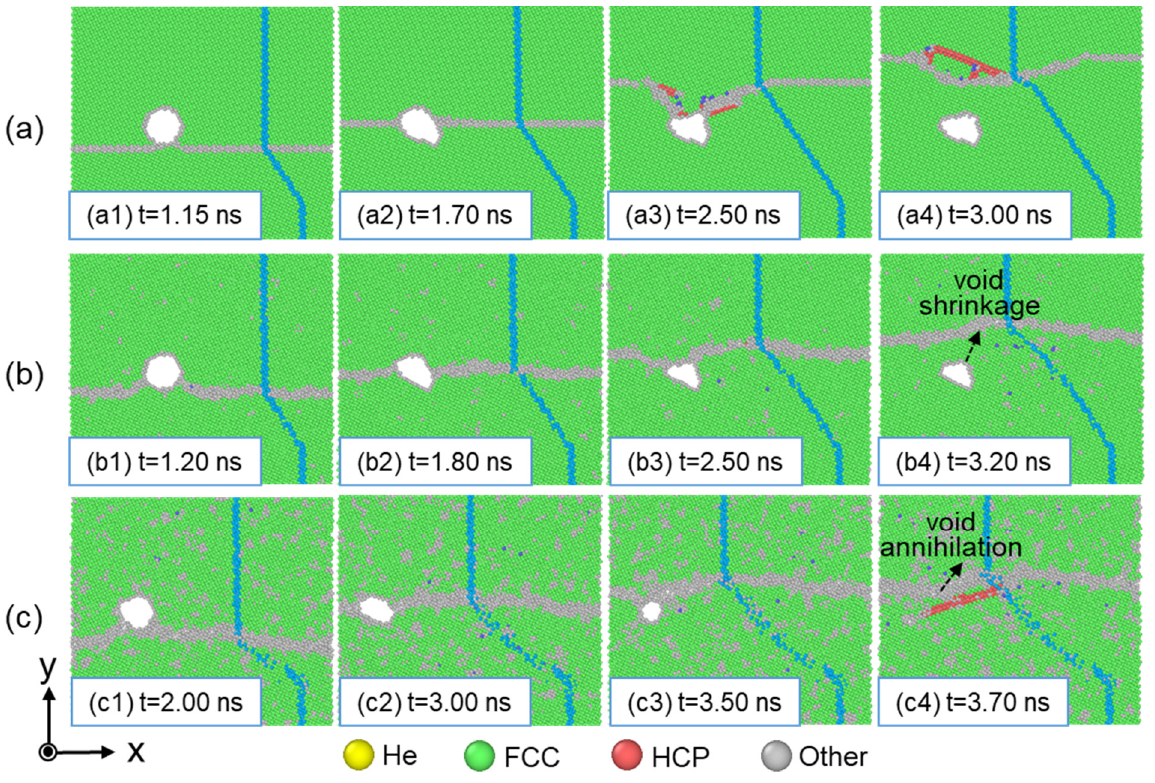
Figure 7. Cross-sectional view of the GB-void interaction with different T 0 . ( a ) 10 K; ( b ) 600 K; ( c ) 900 K.